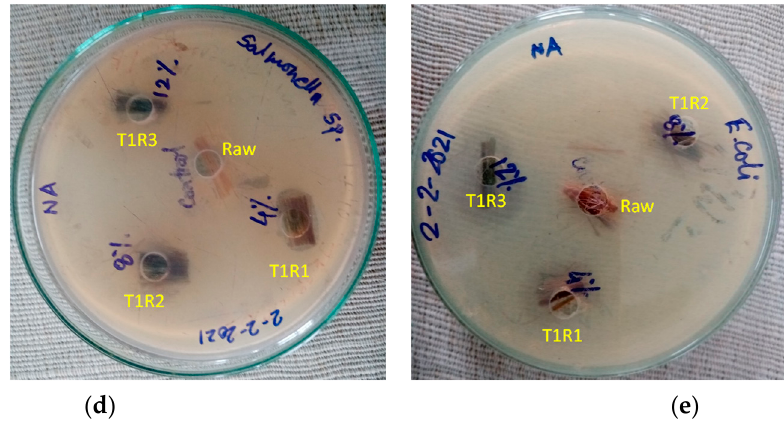
Figure 4. Inhibition zone diameters caused by the rot retardant jute fibers against ( a ) Acinetobacter sp., ( b ) Pseudomonas sp., ( c ) Bacillus cereus , ( d ) Salmonella sp., and ( e ) E. coli.